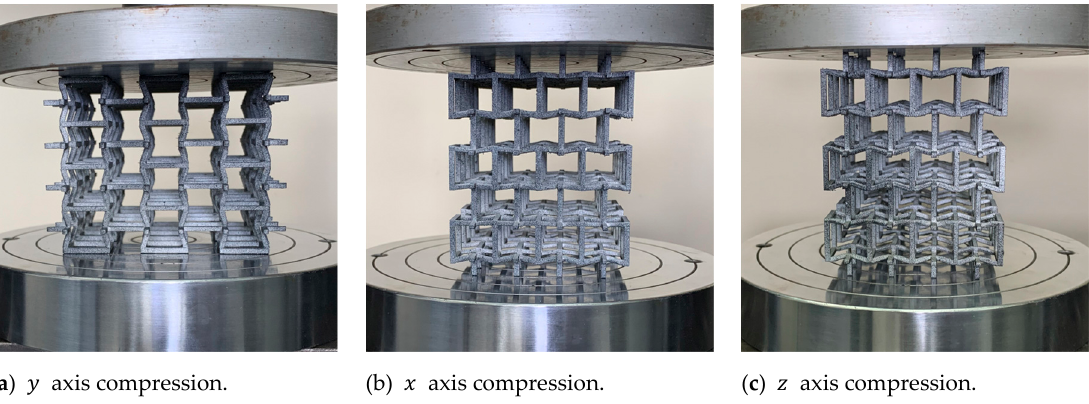
Figure 6. Quasi ‐ static compression tests on each proposed macrostructure in its three orthogonal Figure 6. Quasi-static compression tests on each proposed macrostructure in its three directions. orthogonal